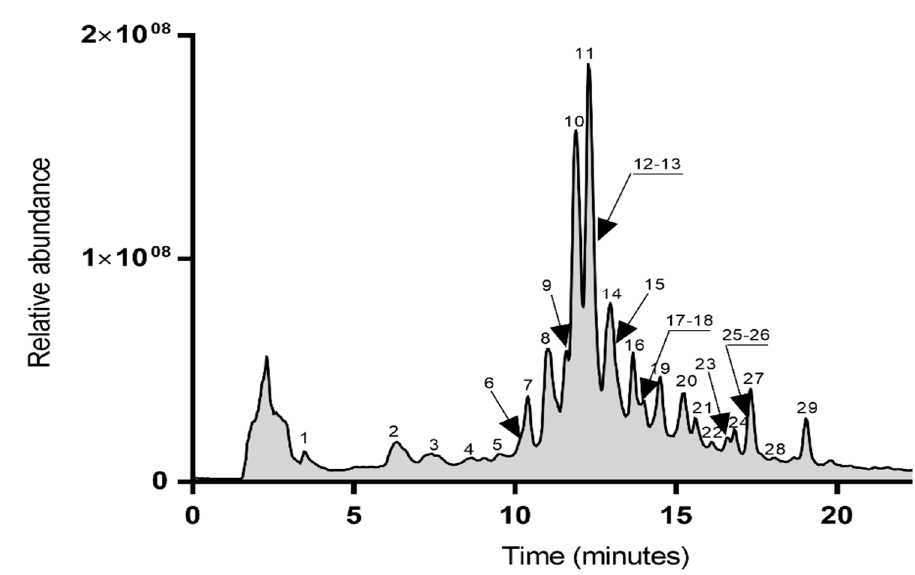
Figure 1. Total ion chromatogram of LC/ESI( − )/MS of the A. arboreum leaf (EtOH–water, 70/30, v/v ) extract.